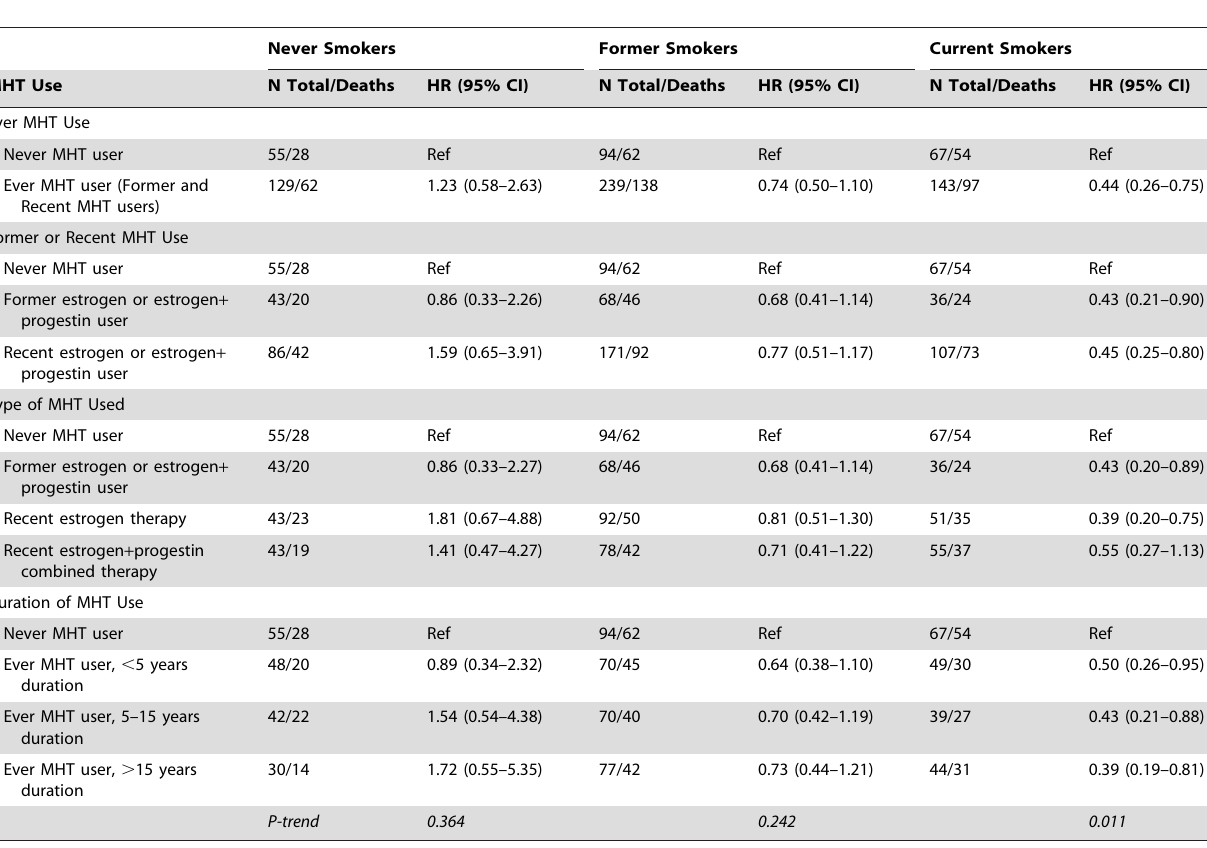
Table 4. Adjusted 1 hazard ratios (HR) and 95% confidence intervals (CI) for the association between any menopausal hormone therapy (MHT) use and mortality among 727 postmenopausal women diagnosed with lung cancer after enrollment in the California Teachers Study stratified by smoking status at